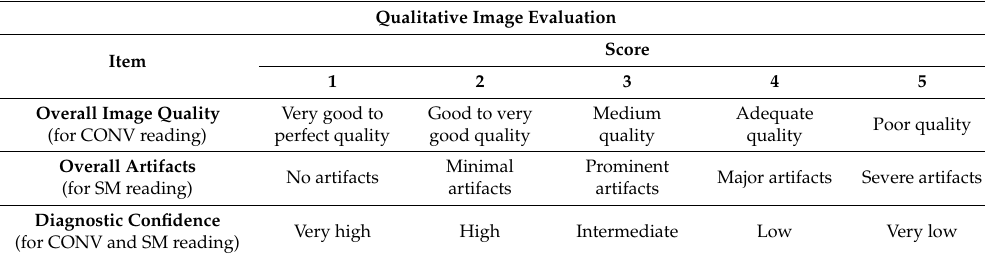
Table 1. Scoring system for visual image